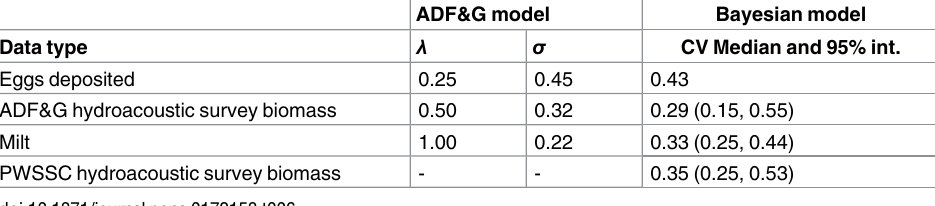
Table 6. Comparison of weights between the ADF&G model and the Bayesianmodel. The first column lists the weights used in the ADF&G weightedleast squares model ( λ ), the second column shows those weights convertedto standarderrors ( σ ) (Francis, 2011), and the third column shows the coefficientsof varia- tion (CV) used in the Bayesianmodel for the same data. Median and 95% posterior intervalsare shown for the ADF&G hydroacoustic biomassand milt CVs. Sampleerrors were providedfor the years that the egg-deposi- tion survey ran (Eq 1.13), which were combinedwith the assumed value of additional error (0.40; Eq 3.14) to derive total egg depositionCV. Therefore, the median total CV across the survey years is presented for